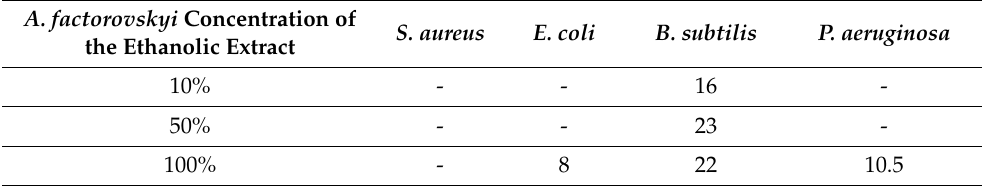
Table 3. Screening of the minimal inhibitory concentration (MIC) of A. factorovskyi ethanolic extract measuring the inhibition zone (mm) for bacterial strains.